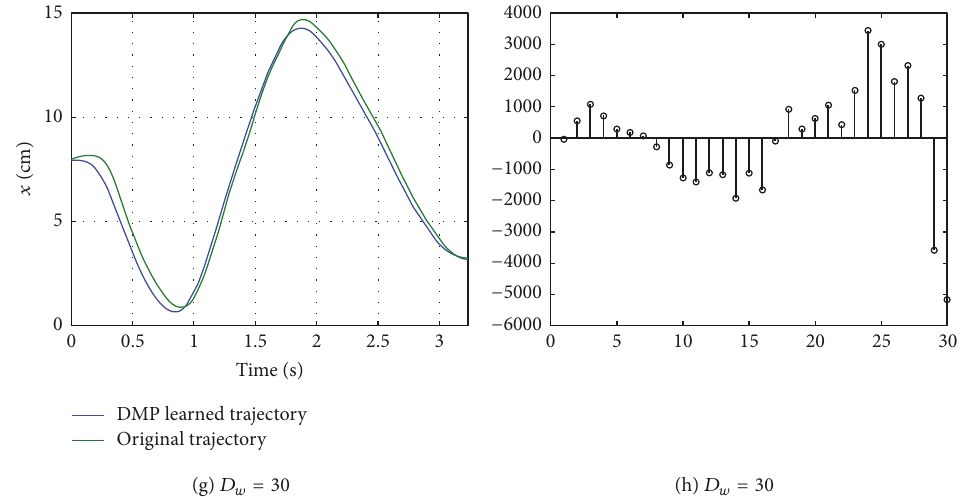
Figure 16: (a), (c), (e), and (g) are the comparisons between DMP learned trajectories (in blue) and the original trajectories (in green) along with different weight vectors dimension 𝐷 𝑤 . (b), (d), (f), and (h) show the learned weight